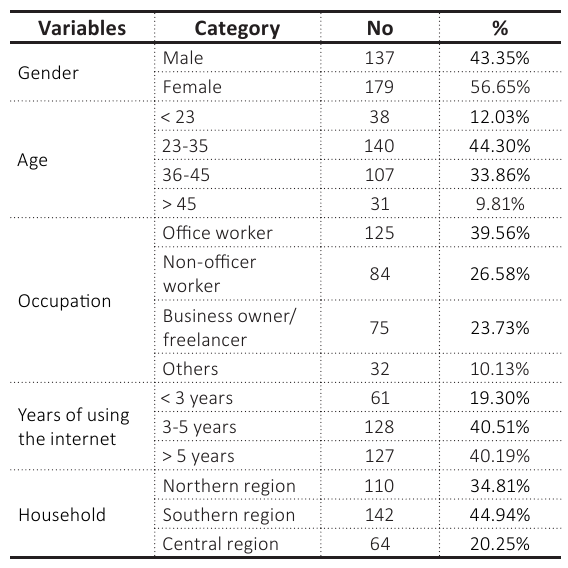
Table 1. Demographical analysis (n = 316)